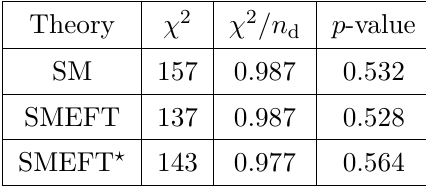
Table 8. The (cid:31) 2 , (cid:31) 2 =n d , and p -values for the SM and SMEFT (cid:12)ts. The middle line is a (cid:12)t to the SMEFT allowing all 20 coe(cid:14)cients to vary, whilst the bottom line assumes a UV-completion of the SMEFT that is renormalizable and weakly-coupled, indicated with a ? . These assumptions allow just 13 non-zero coe(cid:14)cients, and in the Warsaw basis the coe(cid:14)cients set to zero in this case are C G , C W , C HG , C HW , C HB , C HWB , and C uG